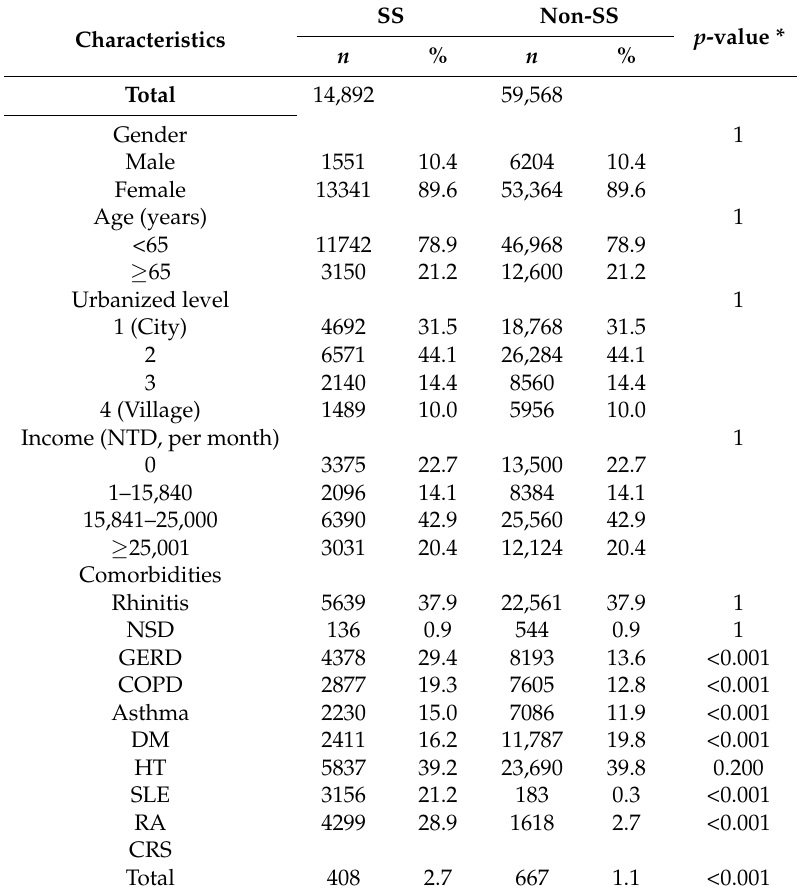
Table 1. Baseline characteristics of study